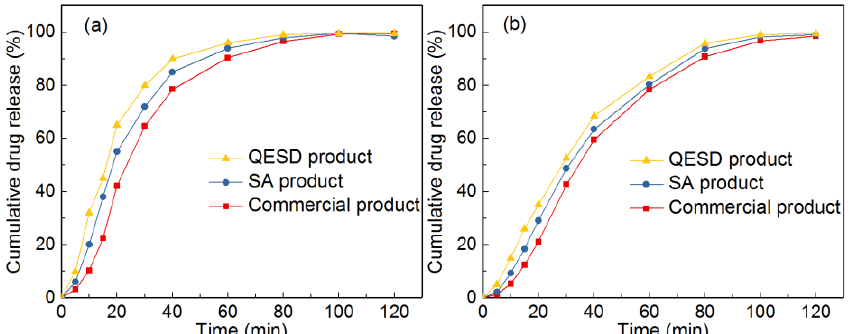
Figure 15. Dissolution profiles of the commercial product, SA product and QESD product at different